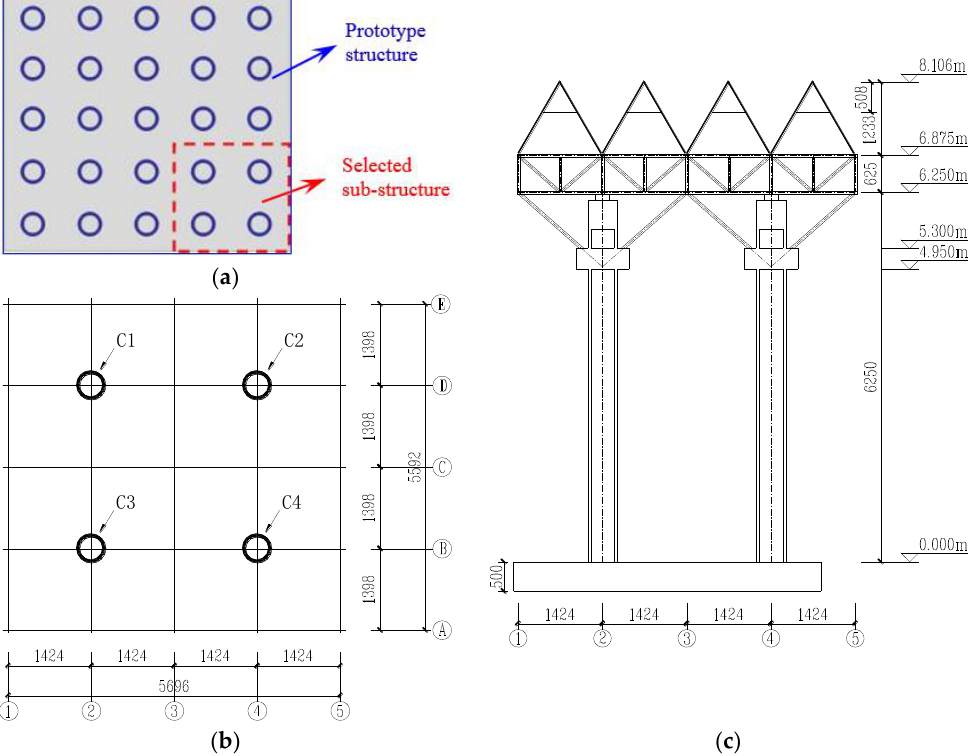
Figure 3. Layouts and dimensions of test specimen (unit: mm): ( a ) Sub-structure selected from the prototype structure; ( b ) Plan layout of reinforced concrete (RC) tubular columns; ( c ) Elevation view along the direction of A-shaped frames.